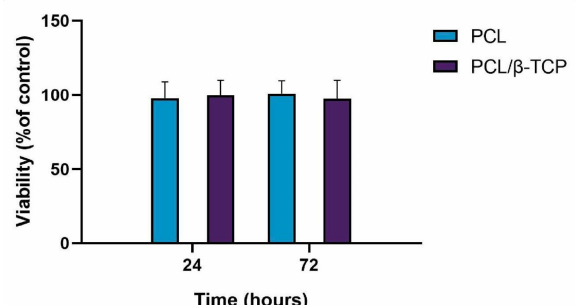
Figure 5. Cell viability using the AlamarBlue assay after 24 and 72 h of direct seeding of ah -BM-MSCs on PCL and PCL/ β -TCP scaffolds. The mean percentage of viability was calculated and normalized with respect to the viability of cells growing on bare plastic (TCPs) (positive control). Bars represent standard deviations of the